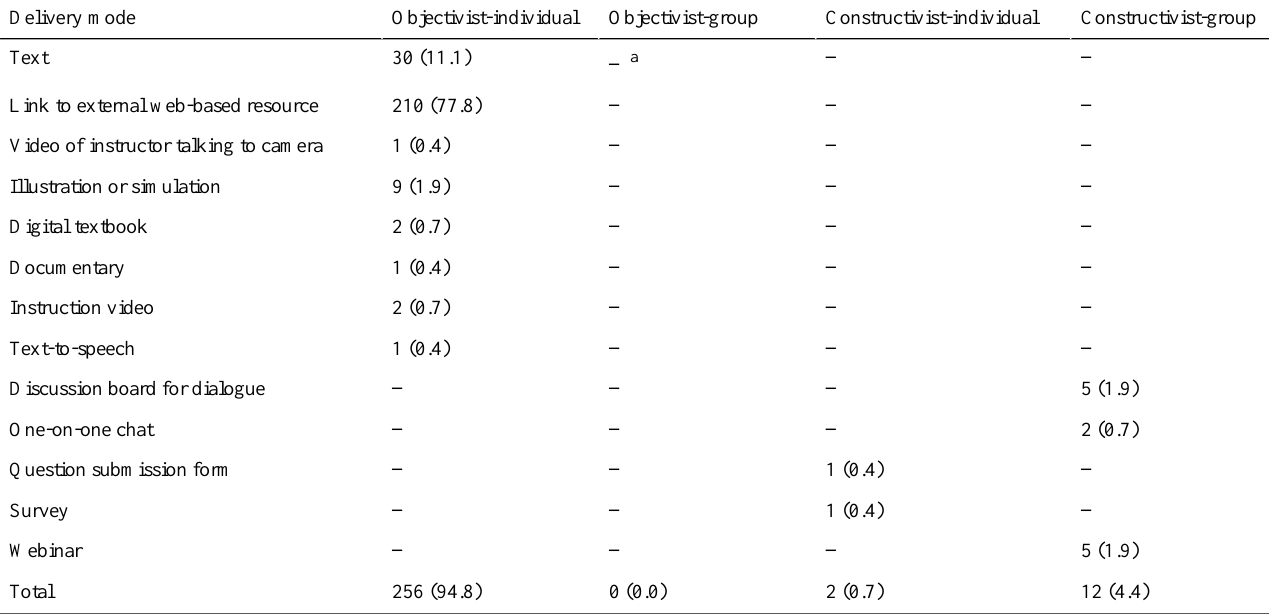
Table 3. Social-epistemological dimensions of the delivery modes based on analysis of the social-epistemological dimensions according to the Teaching